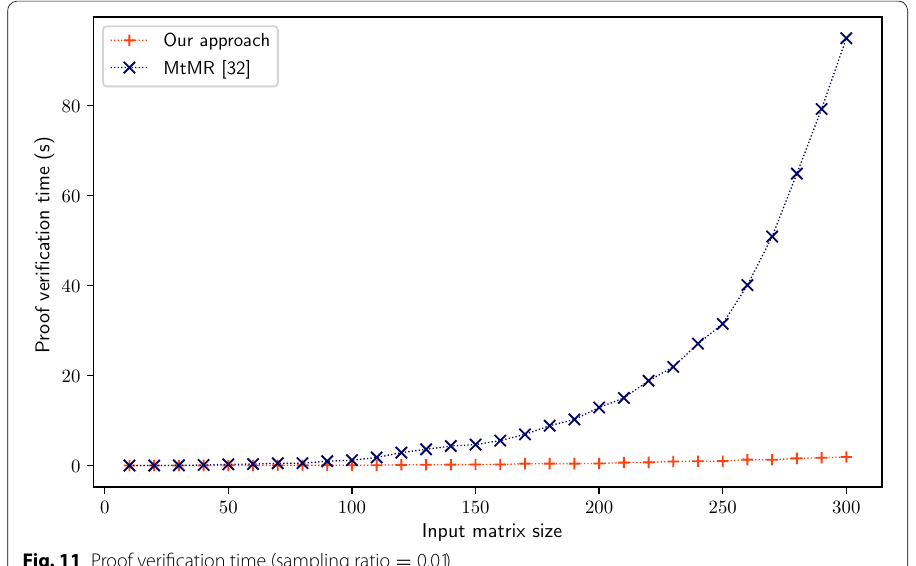
Fig. 11 Proof verification time ( sampling ratio = 0.01